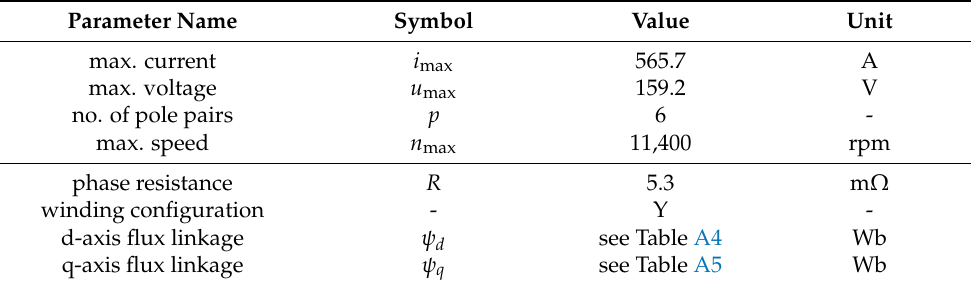
The BMW i3 drive system parameters [20,21] used for the numerical search algorithm